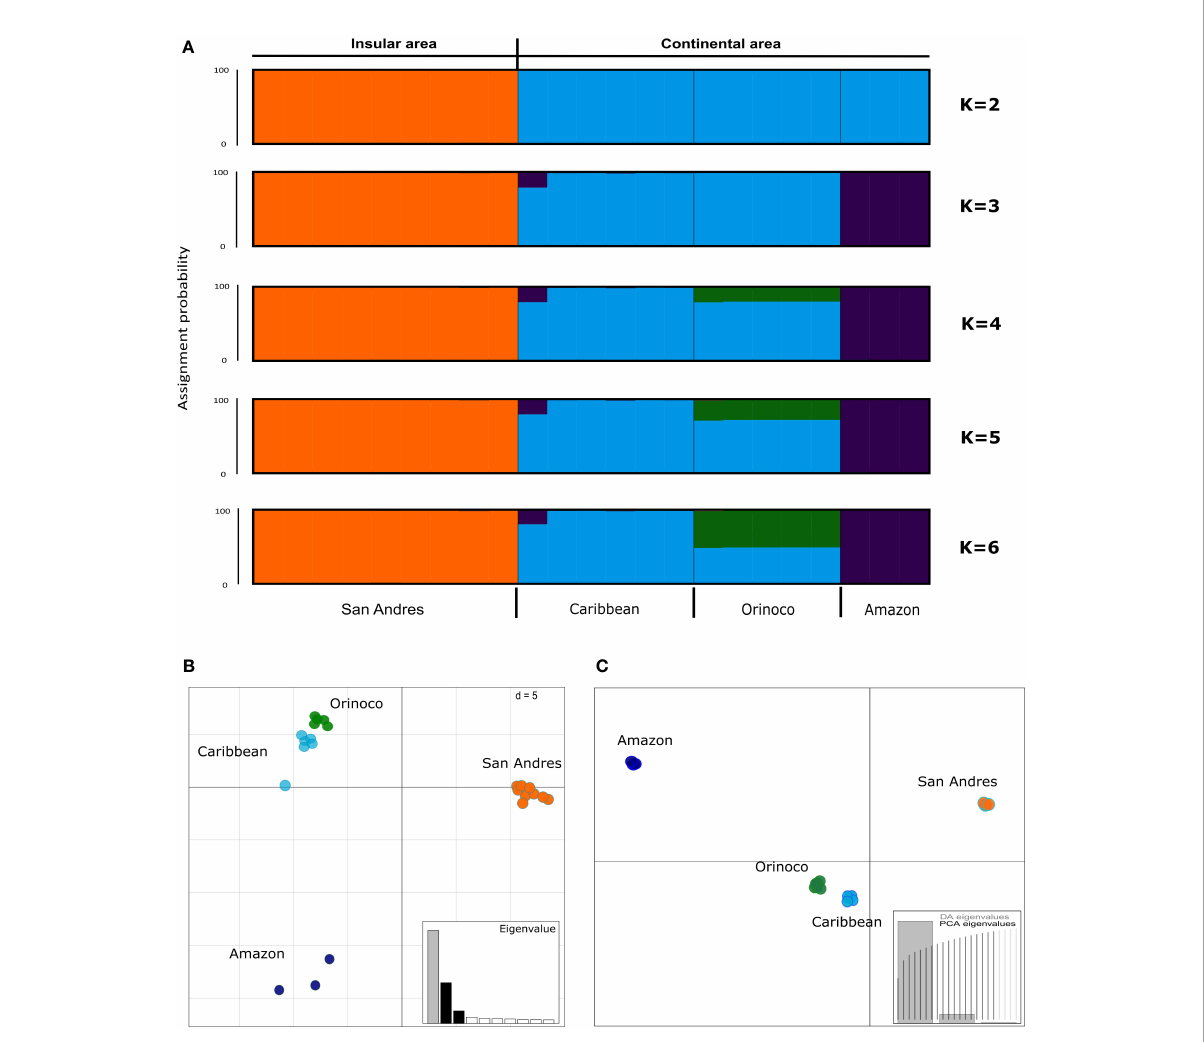
FIGURE 4 Population structure analysis in Kinosternon scorpioides from insular (San Andre ́ s) and continental (Caribbean, Orinoco and Amazon) Colombia, inferred by (A) Bayesian (STRUCTURE), (B) Principal Component Analysis [PCA (ADEGENT)], and (C) Discriminant Analysis of Principal Component [DAPC (ADEGENET)] methods, using 383 SNPs for 23 samples with up to 10% of missing data. STRUCTURE plot is showing the probability of assignment of samples from two (K=2) to six (K=6) groups, being K=2 the more likely according Evanno, and K=4 according Puechmille. Each vertical bar represents one individual. The STRUCTURE (K=4), PCA and DAPC are showing four independent clusters (San Andre ́ s, Caribbean, Orinoco and Amazon), however, with signals of co-ancestry or overlapping between Caribbean and